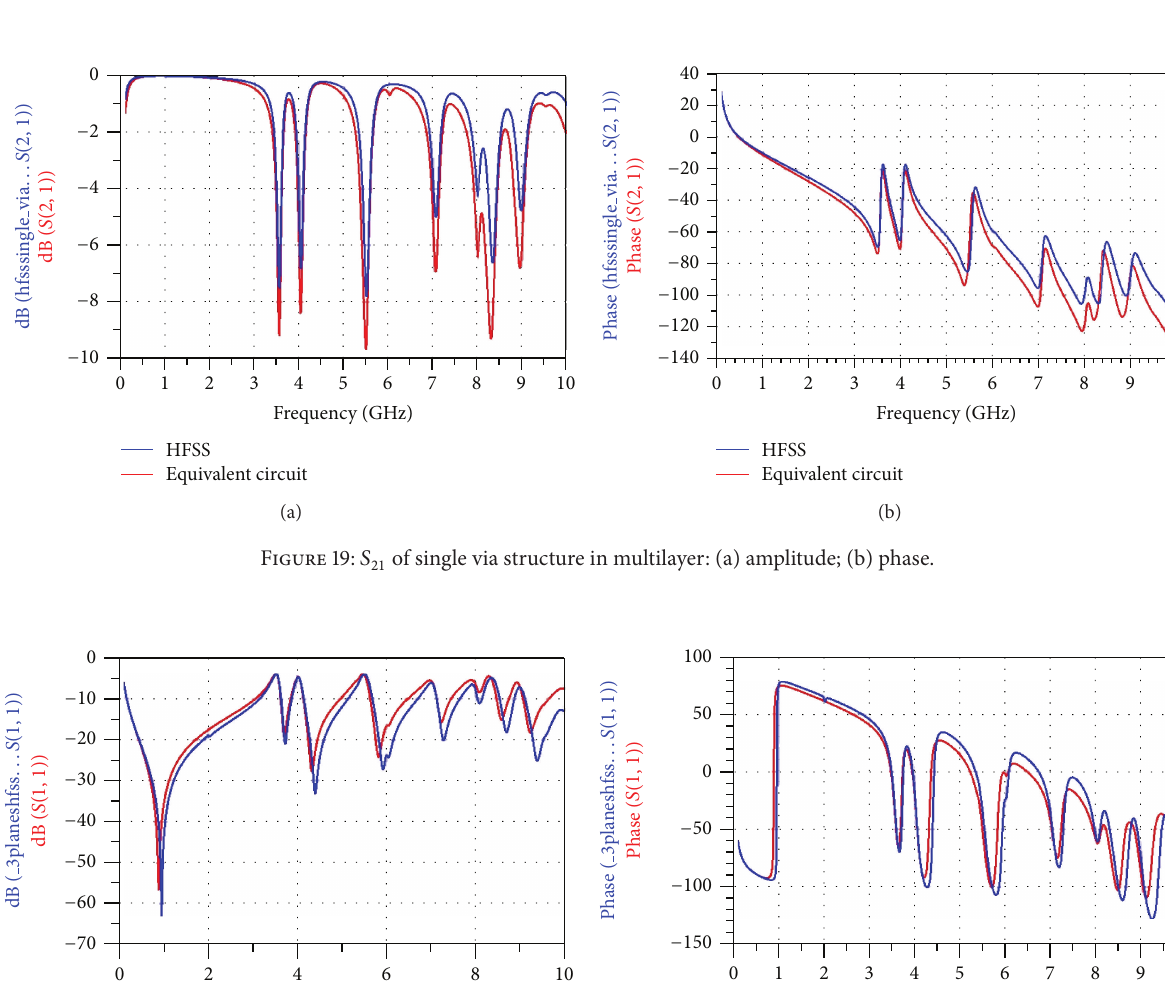
Figure 18: Equivalent circuit of single via in multilayer.